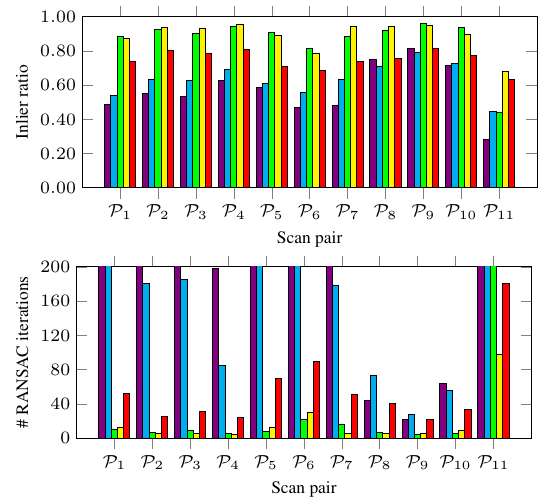
Figure 7. Inlier ratio (top) and number of RANSAC itera- tions (bottom) for the coarse registration of scan pairs P j = {S j , S j +1 } : SIFT (violet), SURF (cyan), ORB (green), A-KAZE + M-SURF (yellow), SURF ∗ + BinBoost (red).